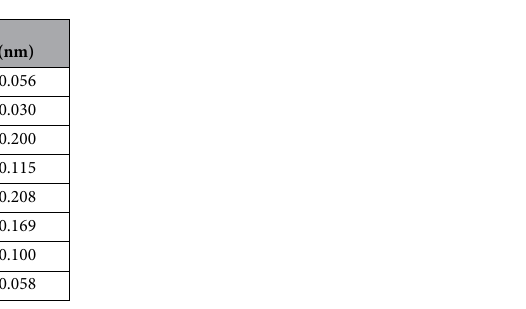
Table 2. Parameters of ELP constructs obtained by turbidity and dynamic light scattering